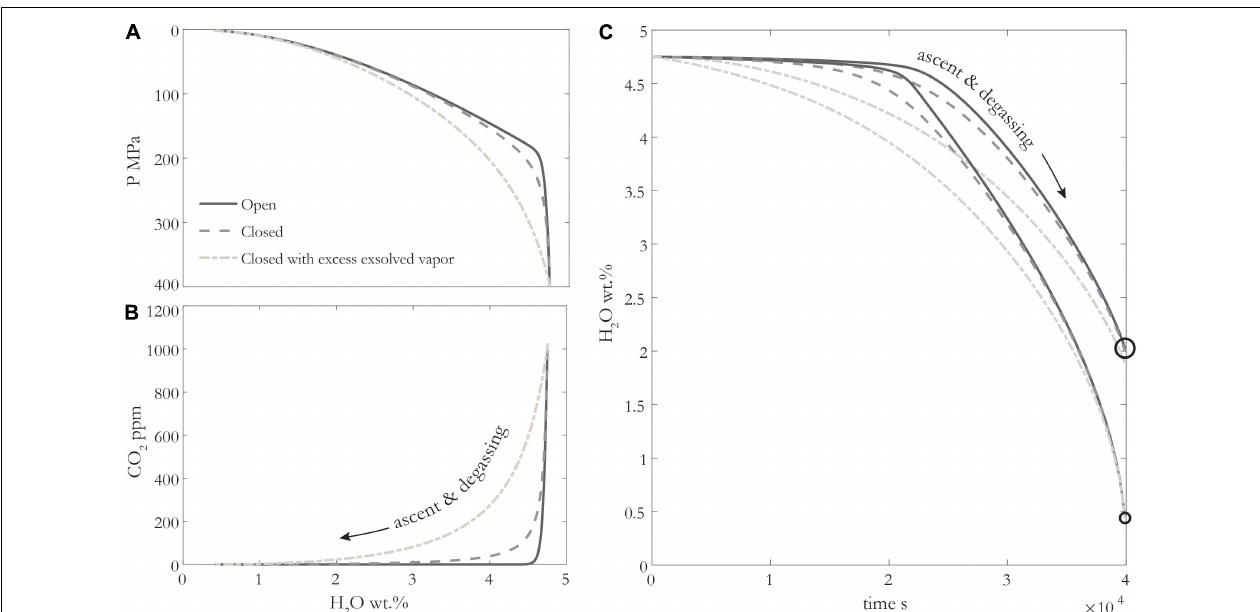
FIGURE 4 | (A,B) Different decompression degassing models for basaltic magma using SolEx (Witham et al., 2012), with 4.75 wt% H 2 O, 1000 ppm CO 2 initially, at 1100 ◦ C and NNO + 1.8. Pale dashed line shows degassing with 6 vol% exsolved fluid at start of simulation. (C) H 2 O-loss from melt inclusions (MIs) over time for different decompression degassing paths in panel (A) and two different MI radii: 1 µ m (small circle) and 10 µ m (large circle). Decompression rate is 0.01 MPa/s, b/a is 10, D is 1.7e-10 m 2 /s, Kd is